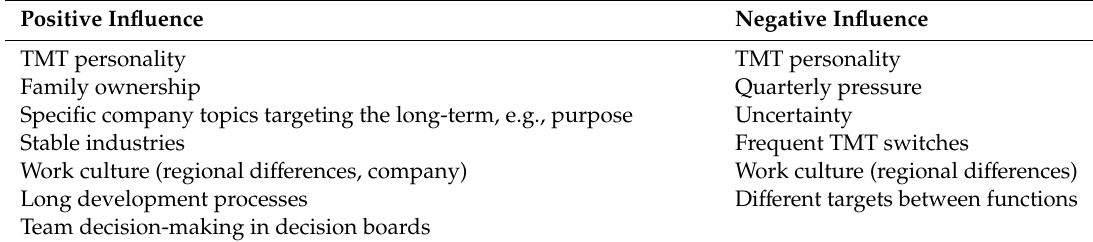
Table 6. Sources for positive and negative influences on the long-term perspective of a TMT that is necessary for sustainability, according to the interview